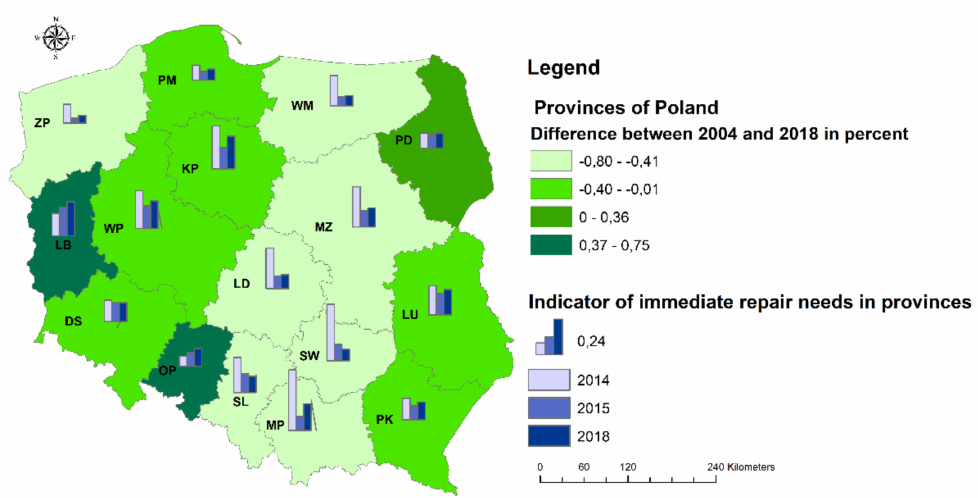
Figure 6. Immediate repair needs in provinces. Source: the authors, based on